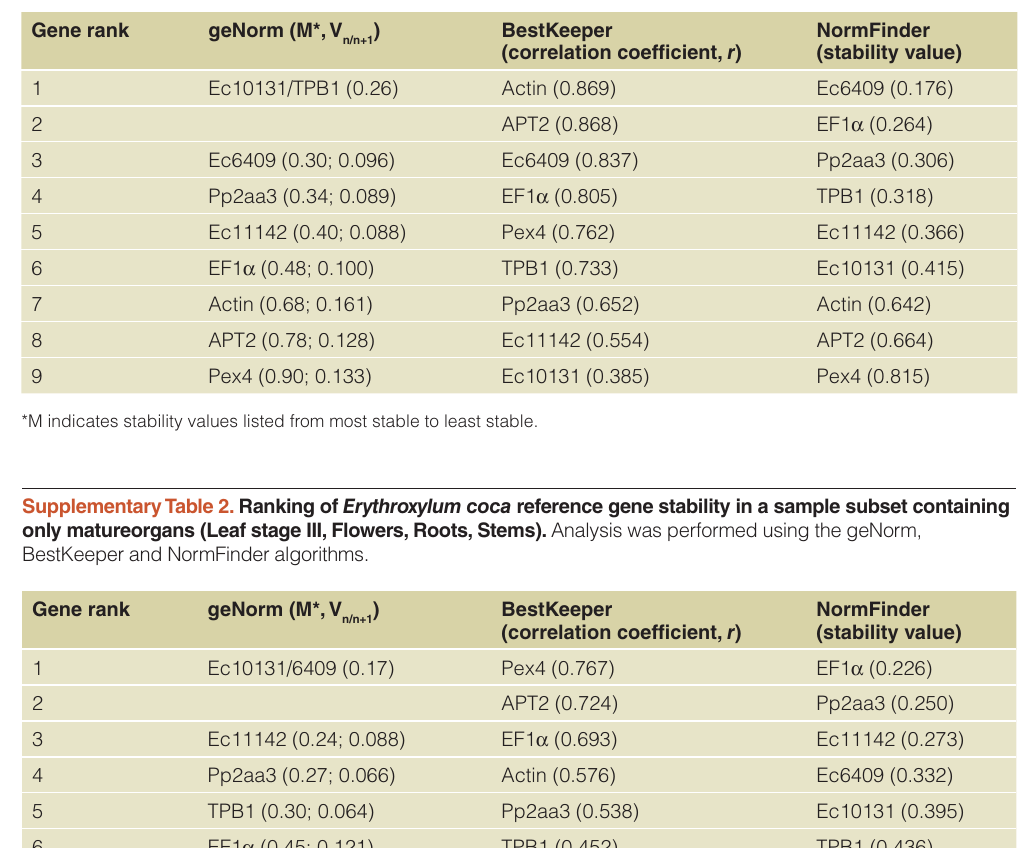
Supplementary Table 1. Ranking of Erythroxylum coca reference gene stability in a sample subset containing only leaf tissues (Buds, Leaf Stage I-III). Analysis was performed using the geNorm, BestKeeper and NormFinder algorithms .